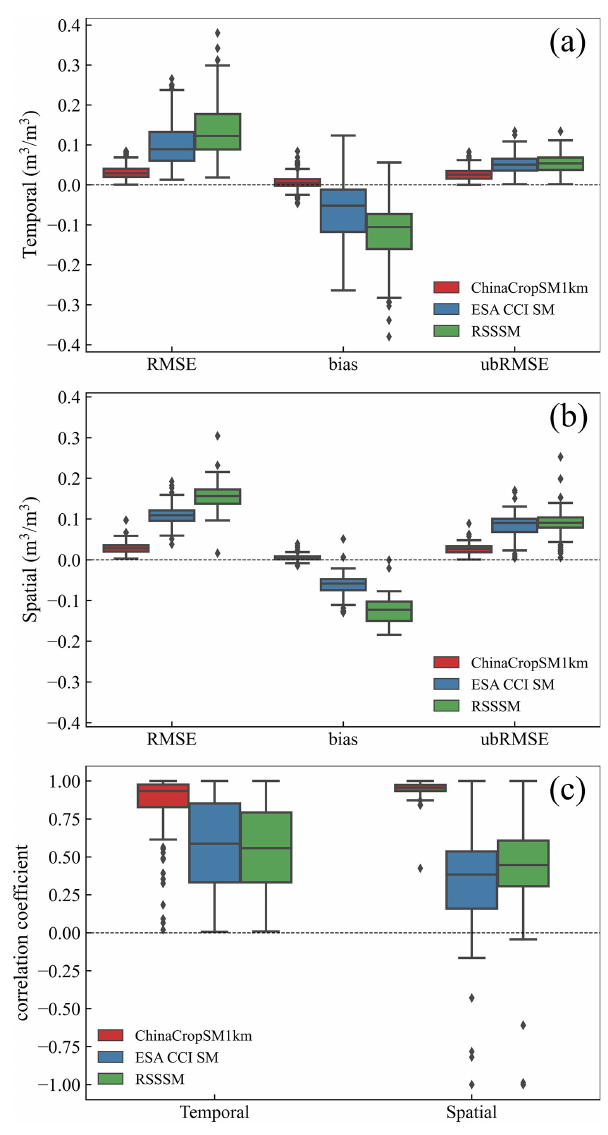
Figure 9. Boxplot of the temporal (a, c) and spatial (b, c) accu- racies for ChinaCropSM1 km, RSSSM and ESA CCI SM by r , bias, RMSE and ubRMSE. These evaluation indices were calcu- lated by comparing the three products with in situ SM observations; the comparison period for ChinaCropSM1 km and RSSSM is from 2003 to 2018, and for ChinaCropSM1 km and ESA CCI SM it is